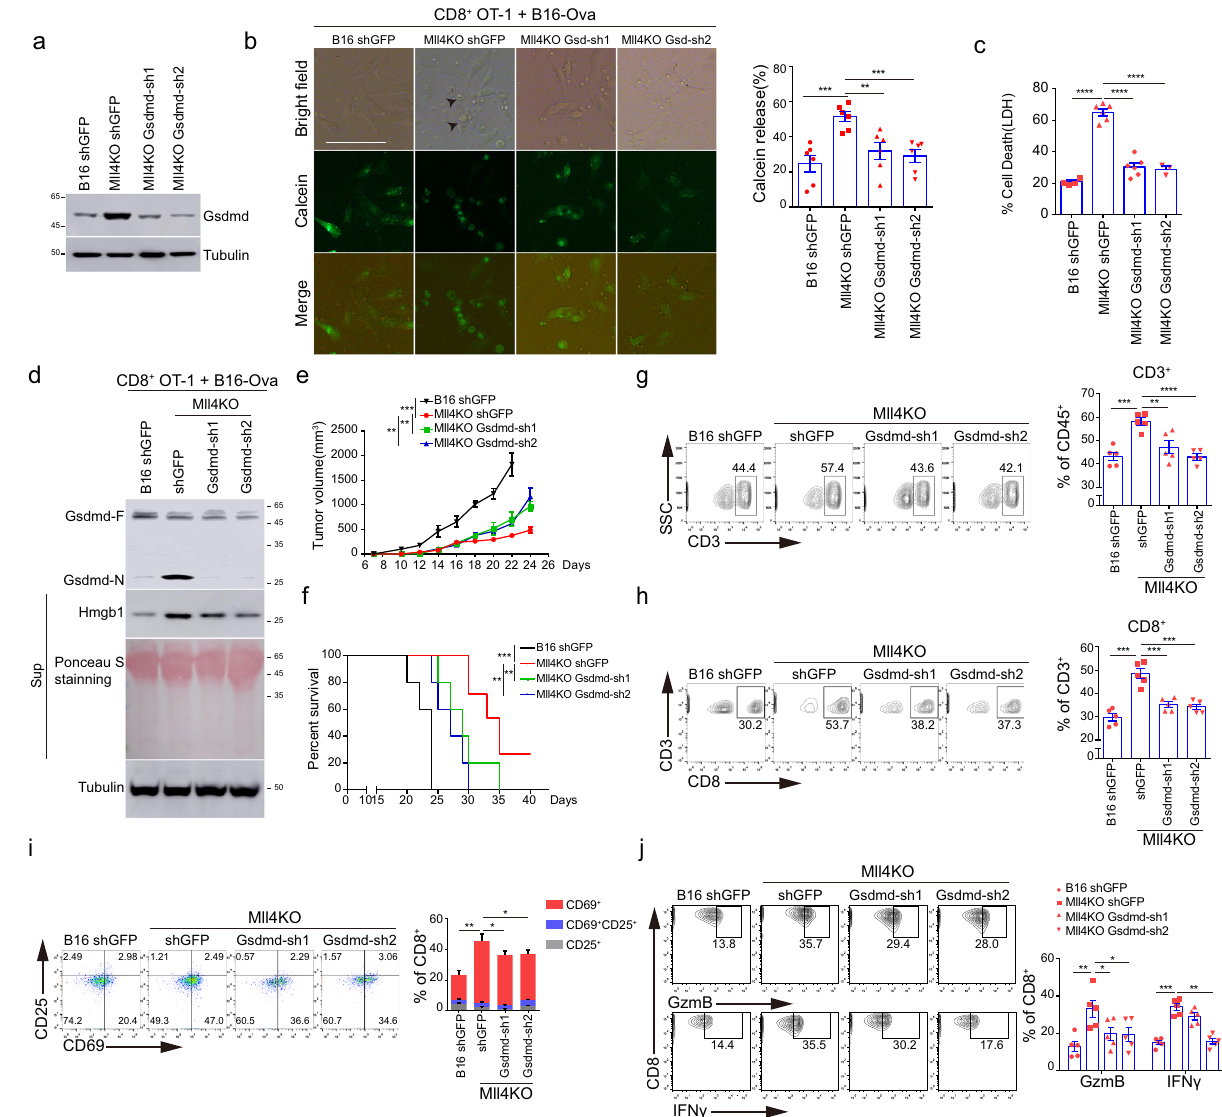
Fig. 5 | GSDMD depletion attenuates tumor-cell pyroptosis and the immuno- suppressiveeffectsofCD8 + Tcellson Mll4 − / − tumors.a GSDMDlevelincontrolor Mll4 − / − B16-Ova cells lentivirally transduced with Gsdmd shRNAs. Shown are representativeresultsfromtwoindependentexperiments. b Controlor Mll4 − / − B16- OvacellsdepletedforGSDMDexpressionwerepreloadedwithcalceinAMandthen co-cultured with OT-I CD8 + T cells at an E/T ratio of 10:1 for 12h. Representative images are shown with arrowheads indicating tumor cells undergoing pyroptosis. Scale bar: 20 μ m. Quanti fi cation of released calcein AM is shown as mean±SEM from fi ve technical replicates in one of two independent experiments c Control or Mll4 − / − B16-Ova cells depleted for GSDMD expression were treated as in ( b ) except for24hofco-culture.T-cell-mediatedkillingwasdeterminedbyLDHrelease-based cell death analysis and shown as mean±SEM from technical triplicates in one